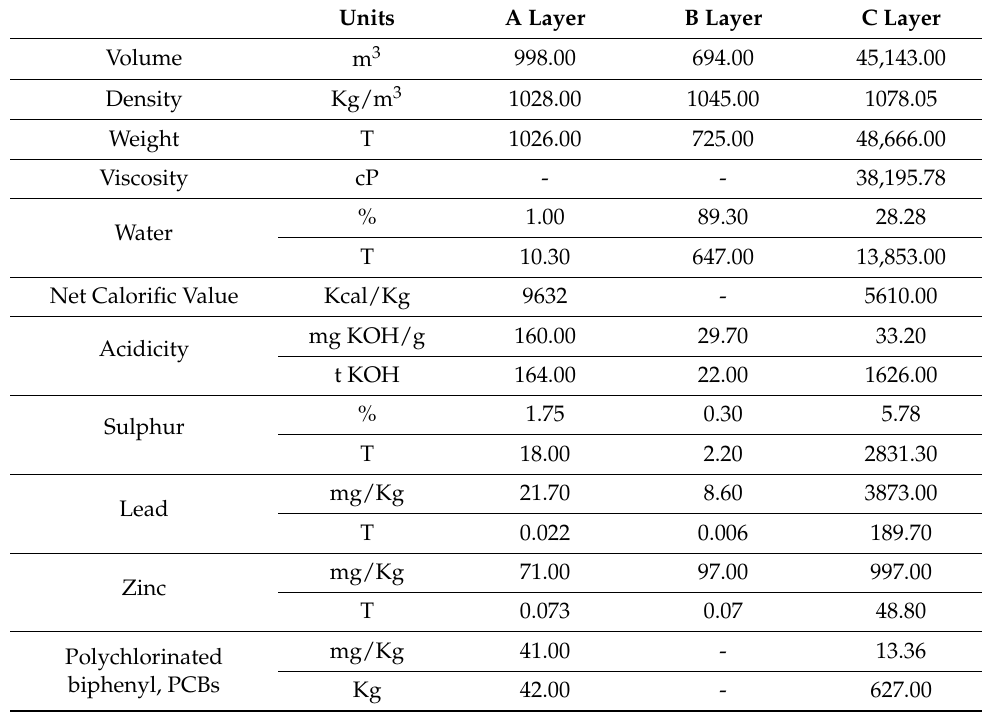
Table 1. Characteristics of the waste from lagoon under this study.